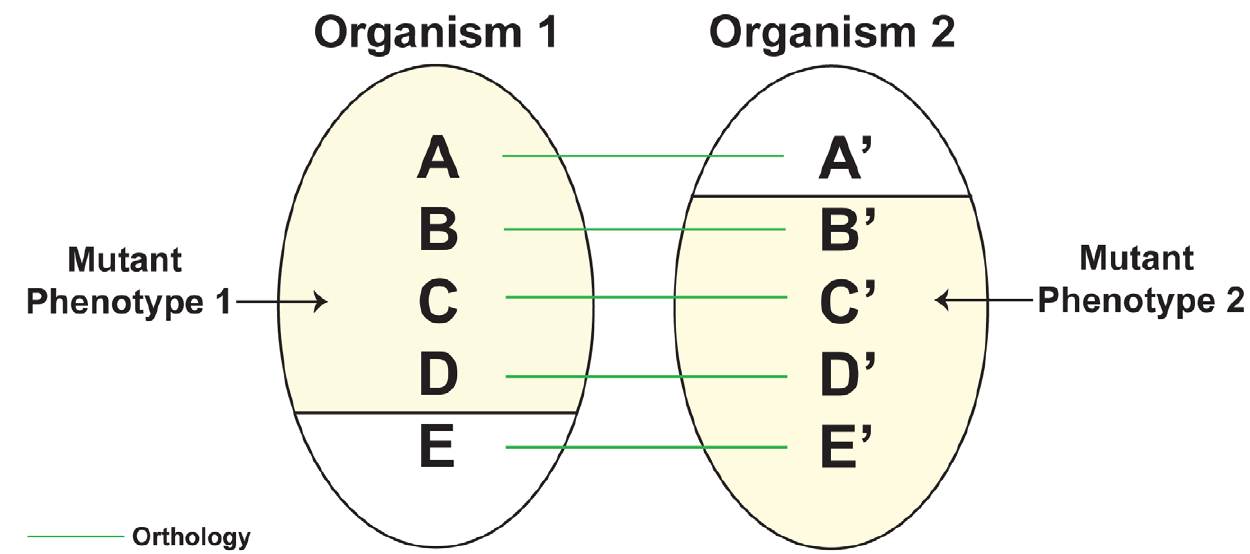
Figure 1. Phenologs.